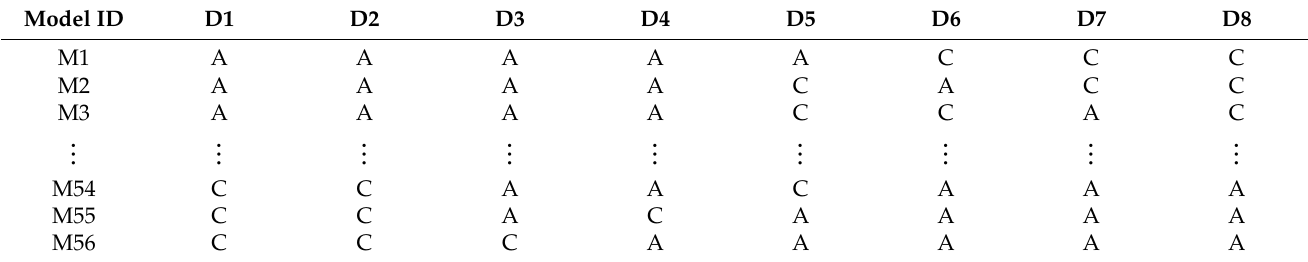
Table 2. Device assignments for the N Mdl = 56 models the N Dev = 8 adapters serving in the indicated Authentic (A) or Counterfeit (C)